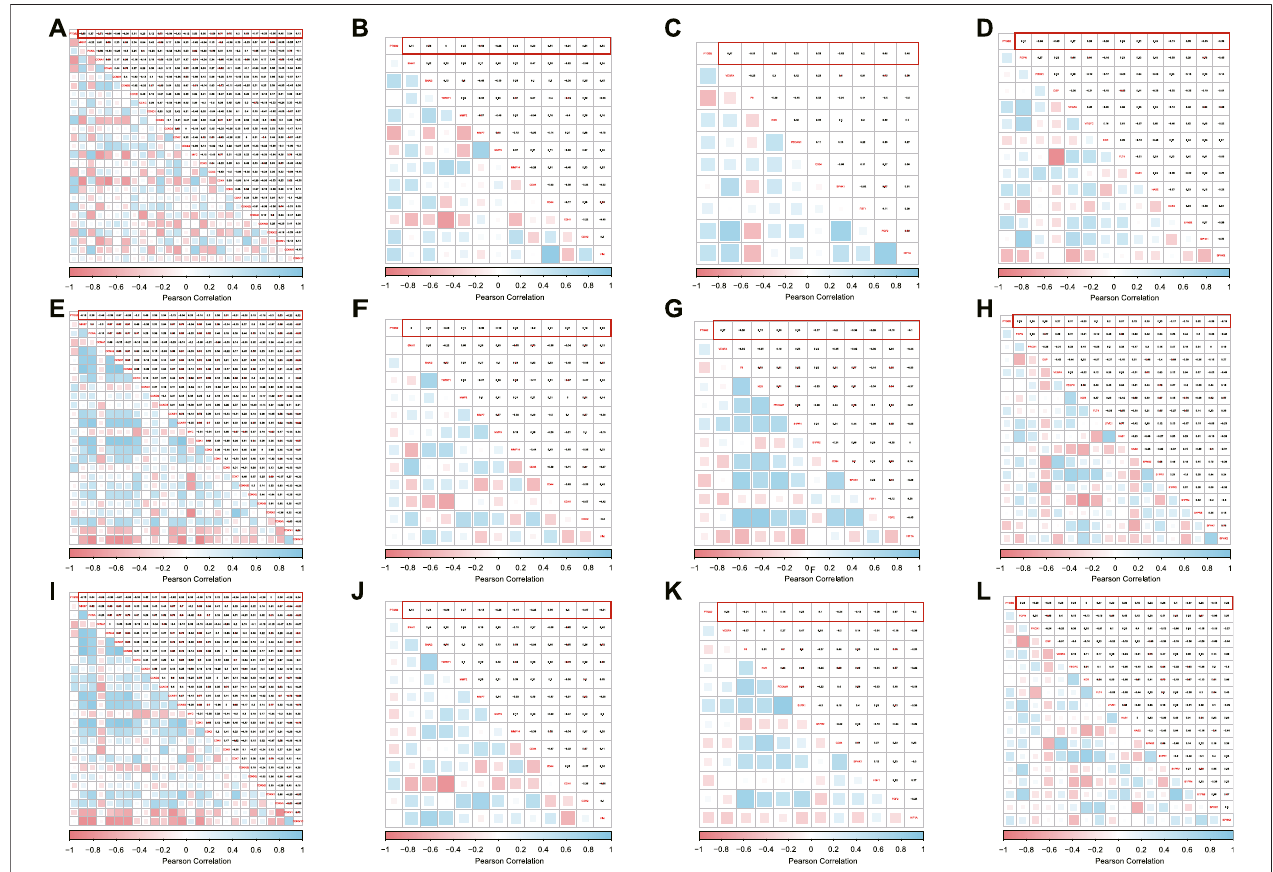
FIGURE 4 | Correlation between PTGS2 expression and cell proliferation/cell cycle regulators were shown as heatmap in GSE48149 (A) , GSE76808 (E) , and GSE81292 (I) ; Correlation between PTGS2 expression and MMPs/EMT and stemness marks were shown as heatmap in GSE48149 (B) , GSE76808 (F) , and GSE81292 (J) ; Correlation between PTGS2 expression and angiogenesis markers were shown as heatmap in GSE48149 (C) , GSE76808 (G) , and GSE81292 (K) ; Correlation between PTGS2 expression and lymph-angiogenesis markers were shown as heatmap in GSE48149 (D) , GSE76808 (H) , and GSE81292 (L)